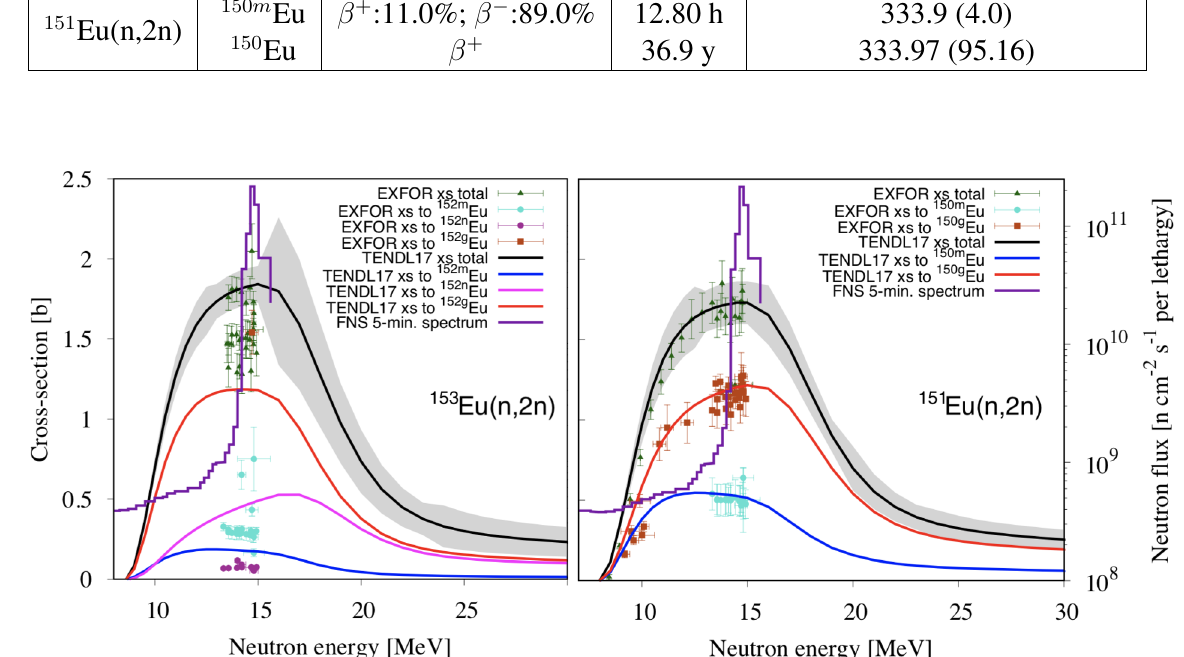
Figure 5: TENDL-2017 evaluated cross-section for 153 Eu(n,2n) and 151 Eu(n,2n) reaction channels along with the EXFOR experimental